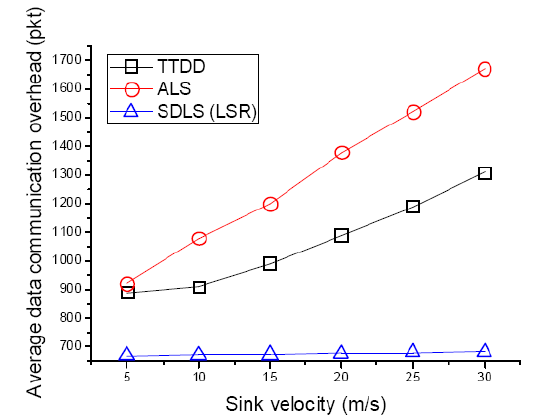
Figure 11. Average data communication